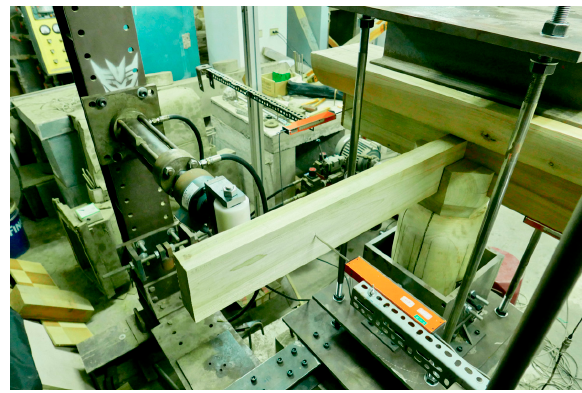
Figure 9. Testing rig and specimen of rotational test. Table 4. Specimens of shear test.